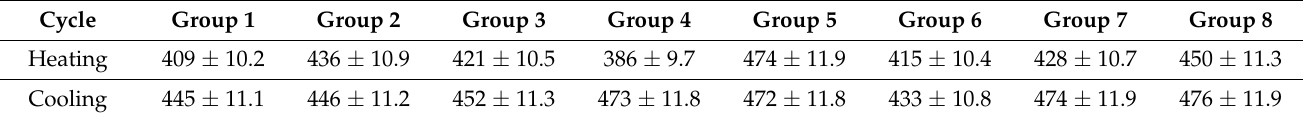
Table 4 contains calculated average specific heat capacity values. Table 4. (cid:104) c p (cid:105) , J/(kg × K) for heating and cooling cycles.